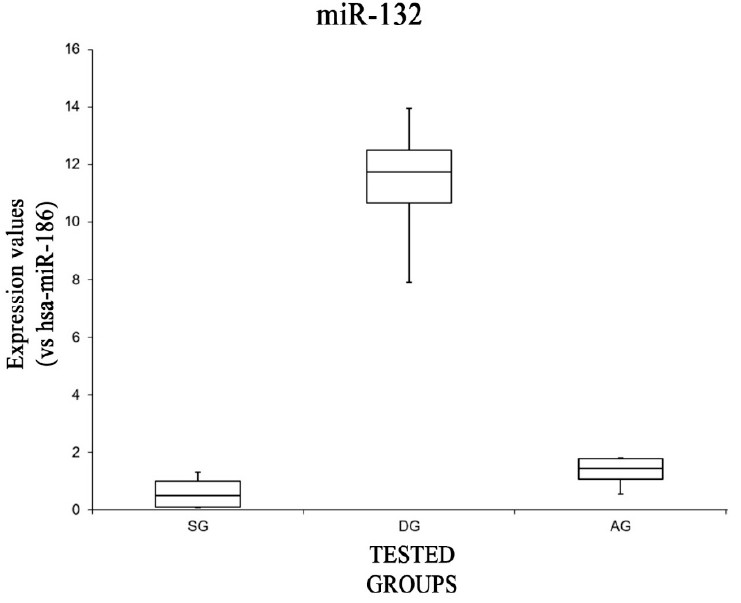
Figure 1. Box plot analysis comparing expression levels of miR-132 (endogenous control miR-186) in each group.